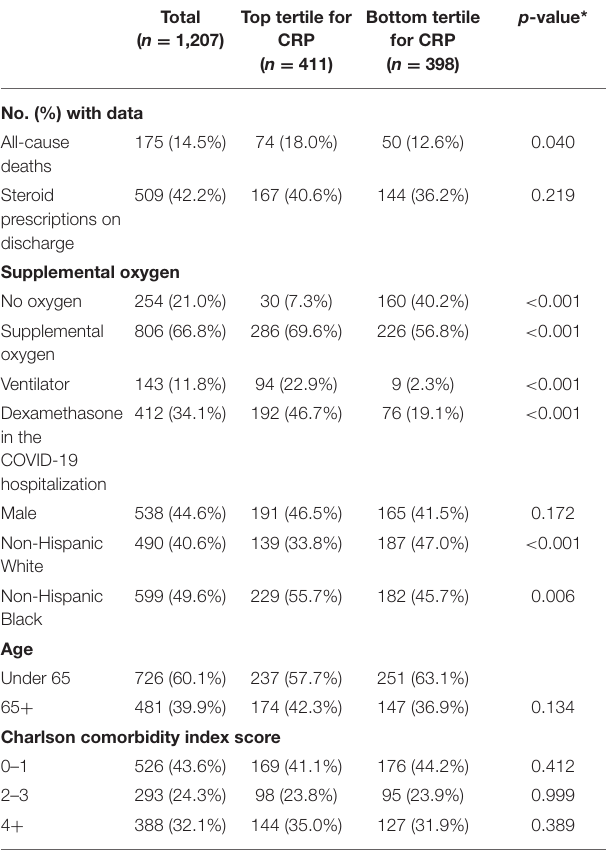
TABLE 1 | Characteristics of the patients in the